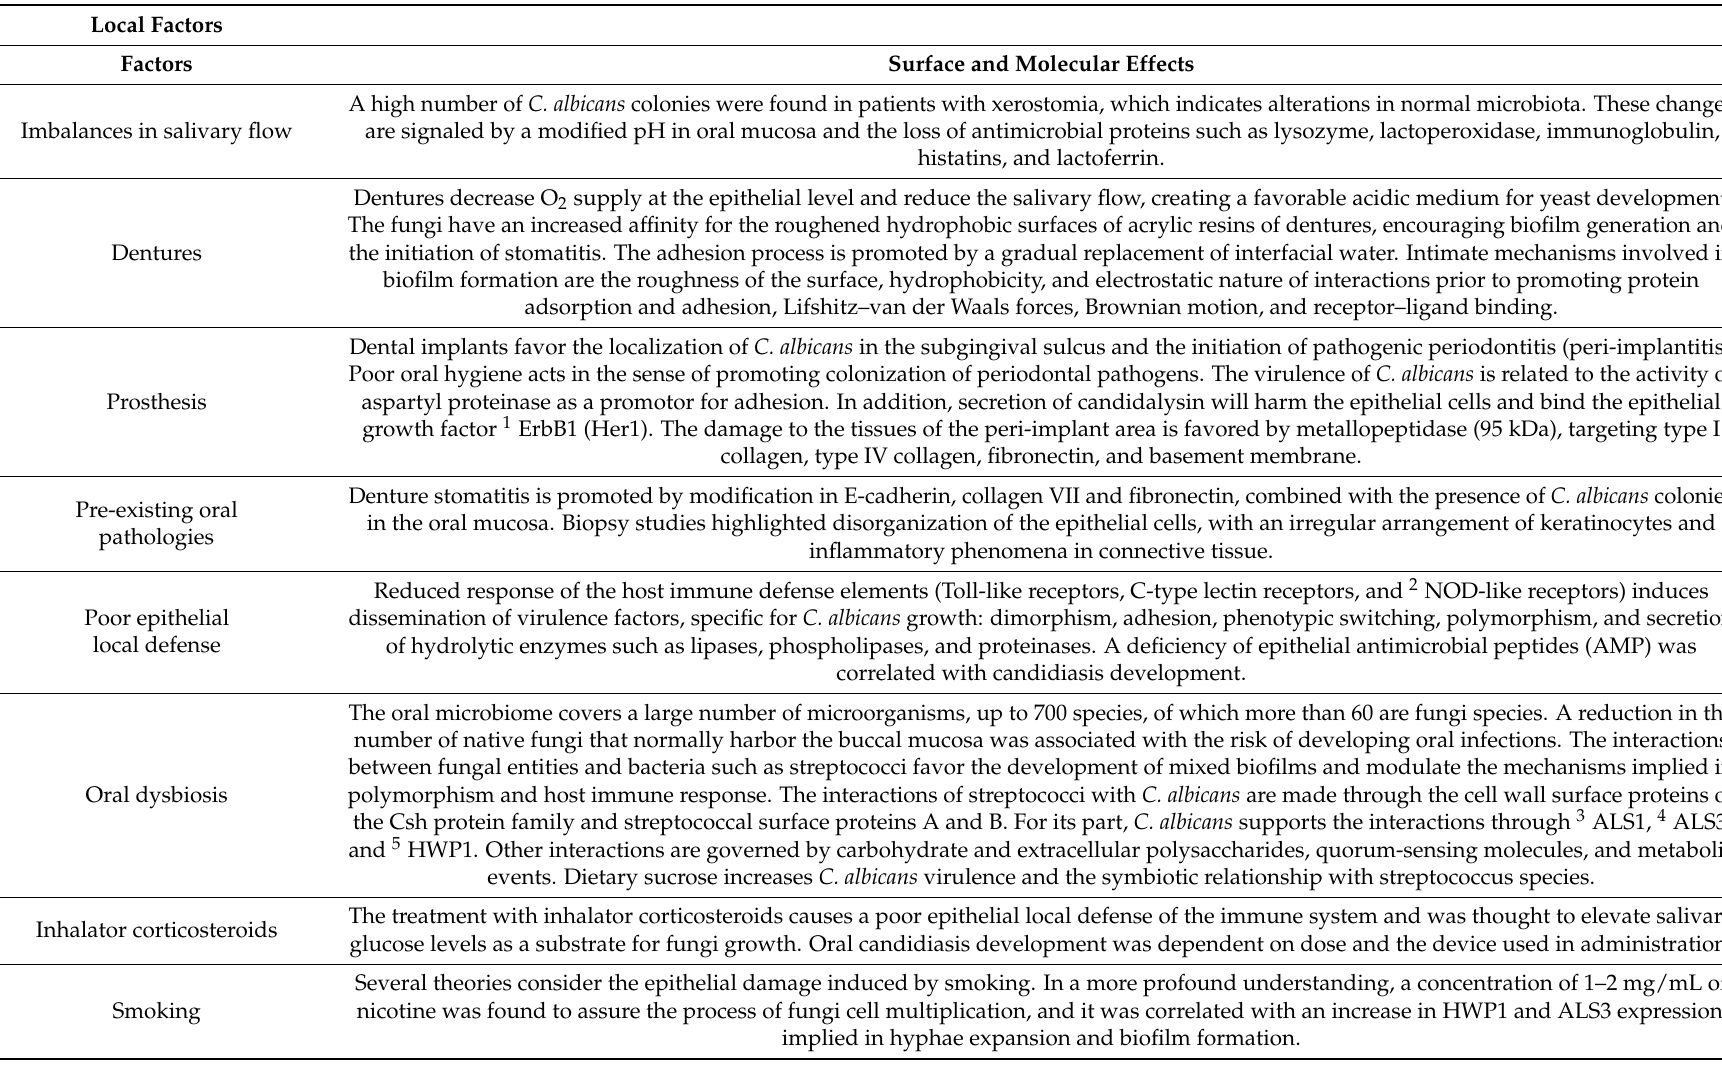
Table 1. Local and systemic triggers defined by surface and molecular changes, involved in candidiasis development and